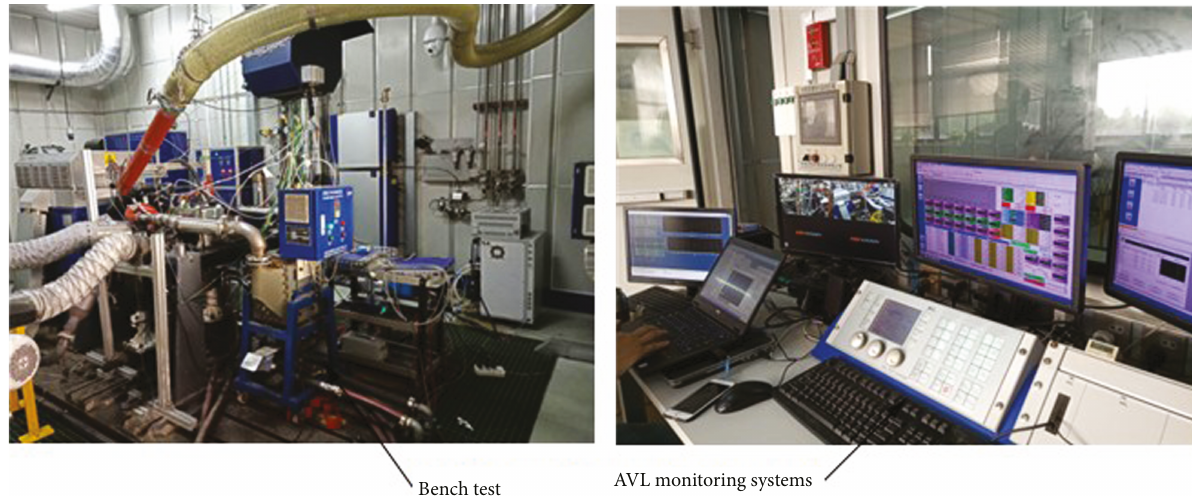
Figure 14: Engine bench test.